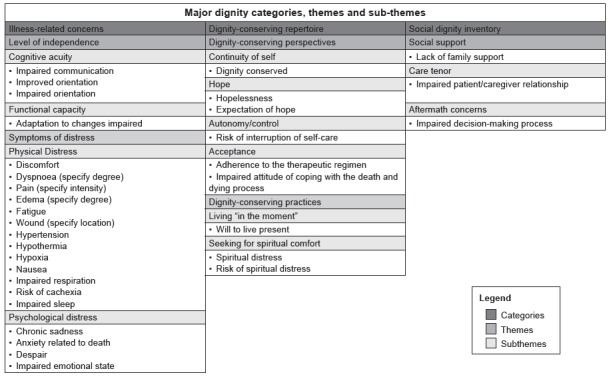
Distribution of NDs in the DCCM categories
9
. Salvador, BA, Brazil, 2014